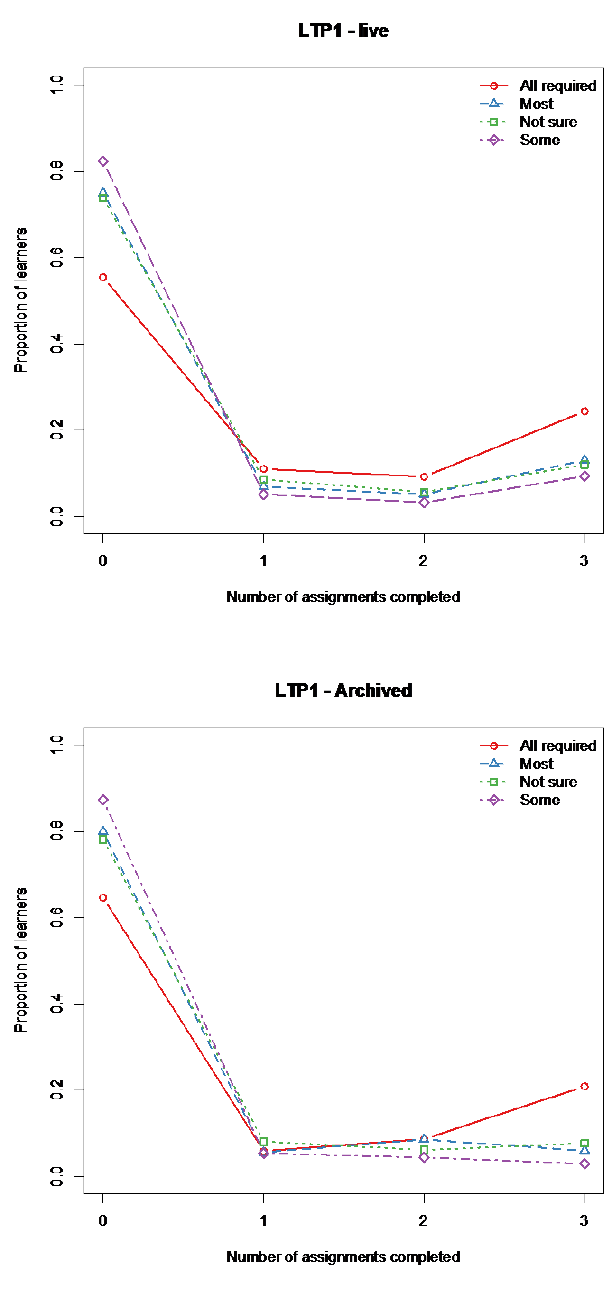
Figure 9. Number of assignments completed by LTP1 live- and archived-learners, by